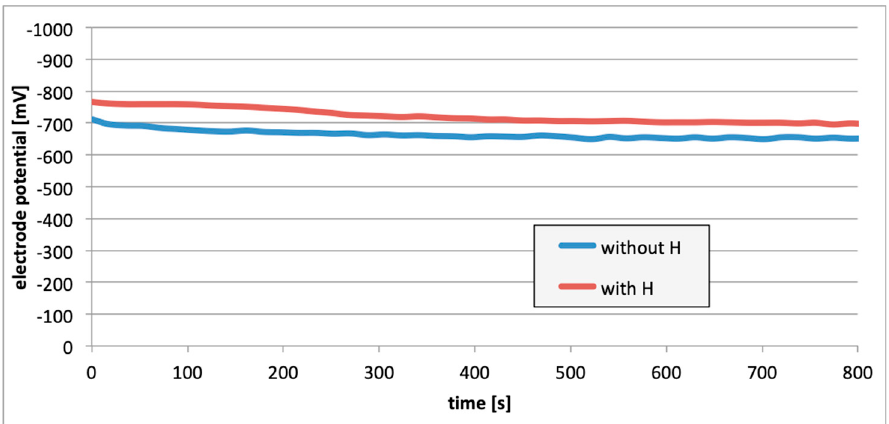
Figure 9. Electrode potential change after the alloy hydrogenation (EN